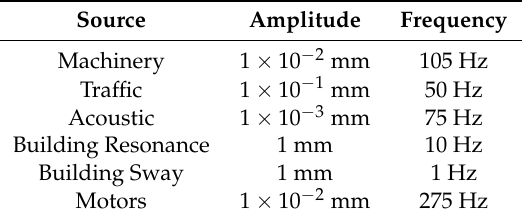
Table 4. Sources of mechanical vibrations with their amplitudes and frequencies